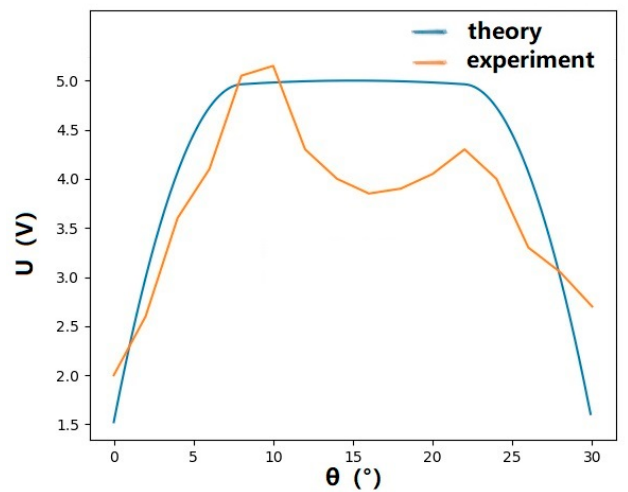
Figure 6. Relationship between the output voltage of the receiving sub module and the departure angle.